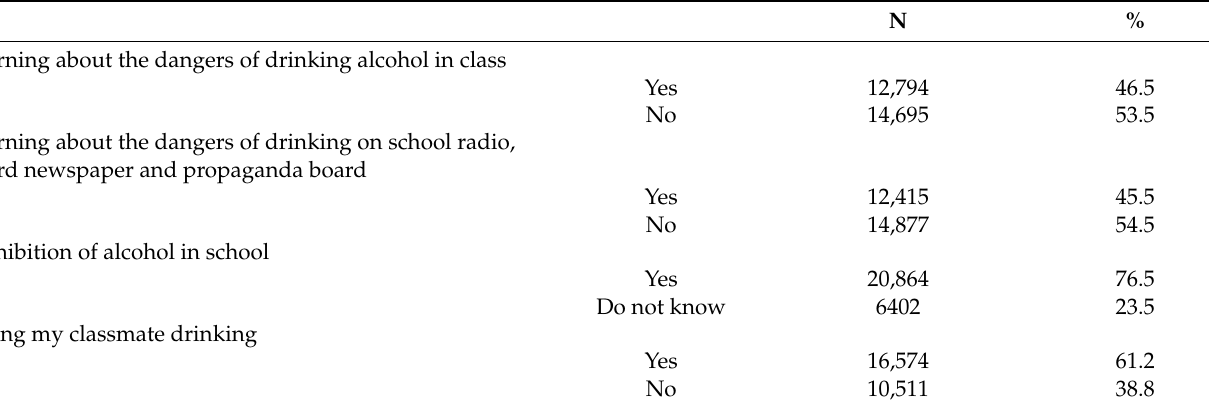
Table 2. School environment regarding alcohol